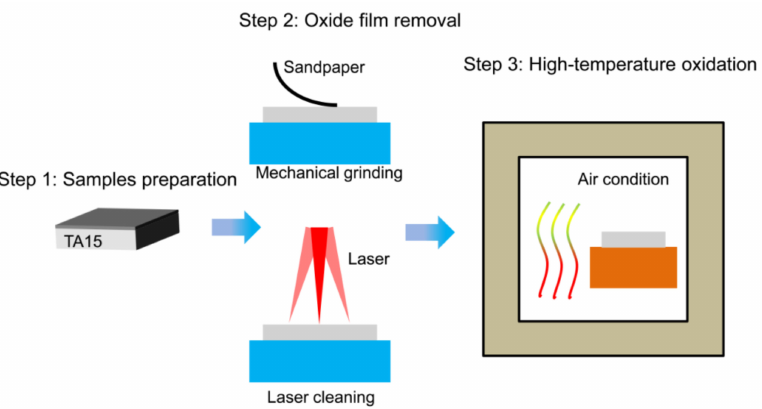
Figure 1. Schematic diagram of experimental scheme.